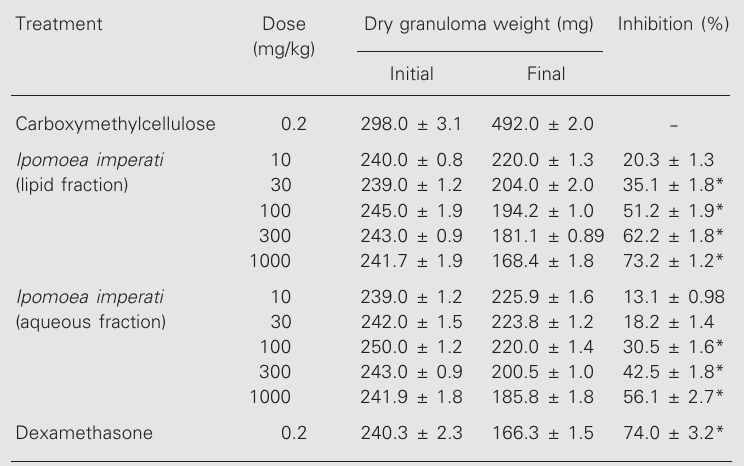
Table 2. Effect of the oral administration of Ipomoea imperati leaf lipid and aqueous extracts on rat granuloma tissue formation. Treatment